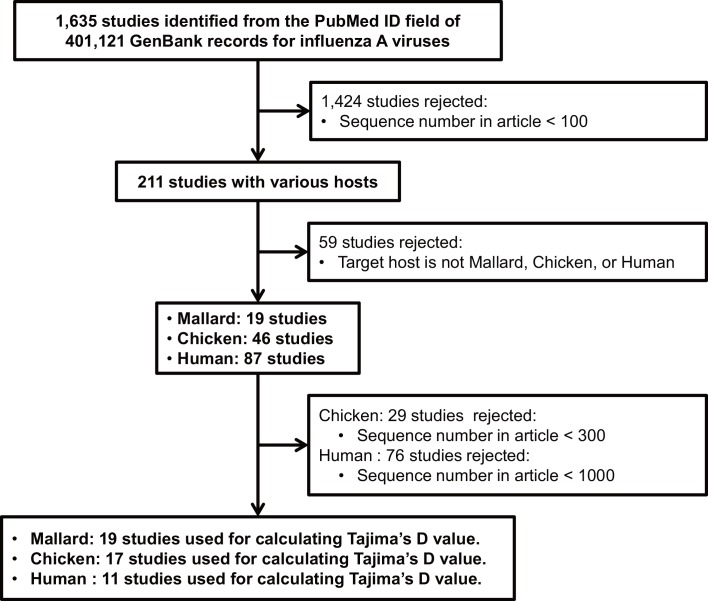
The selection process of systematic review of surveillance studies.